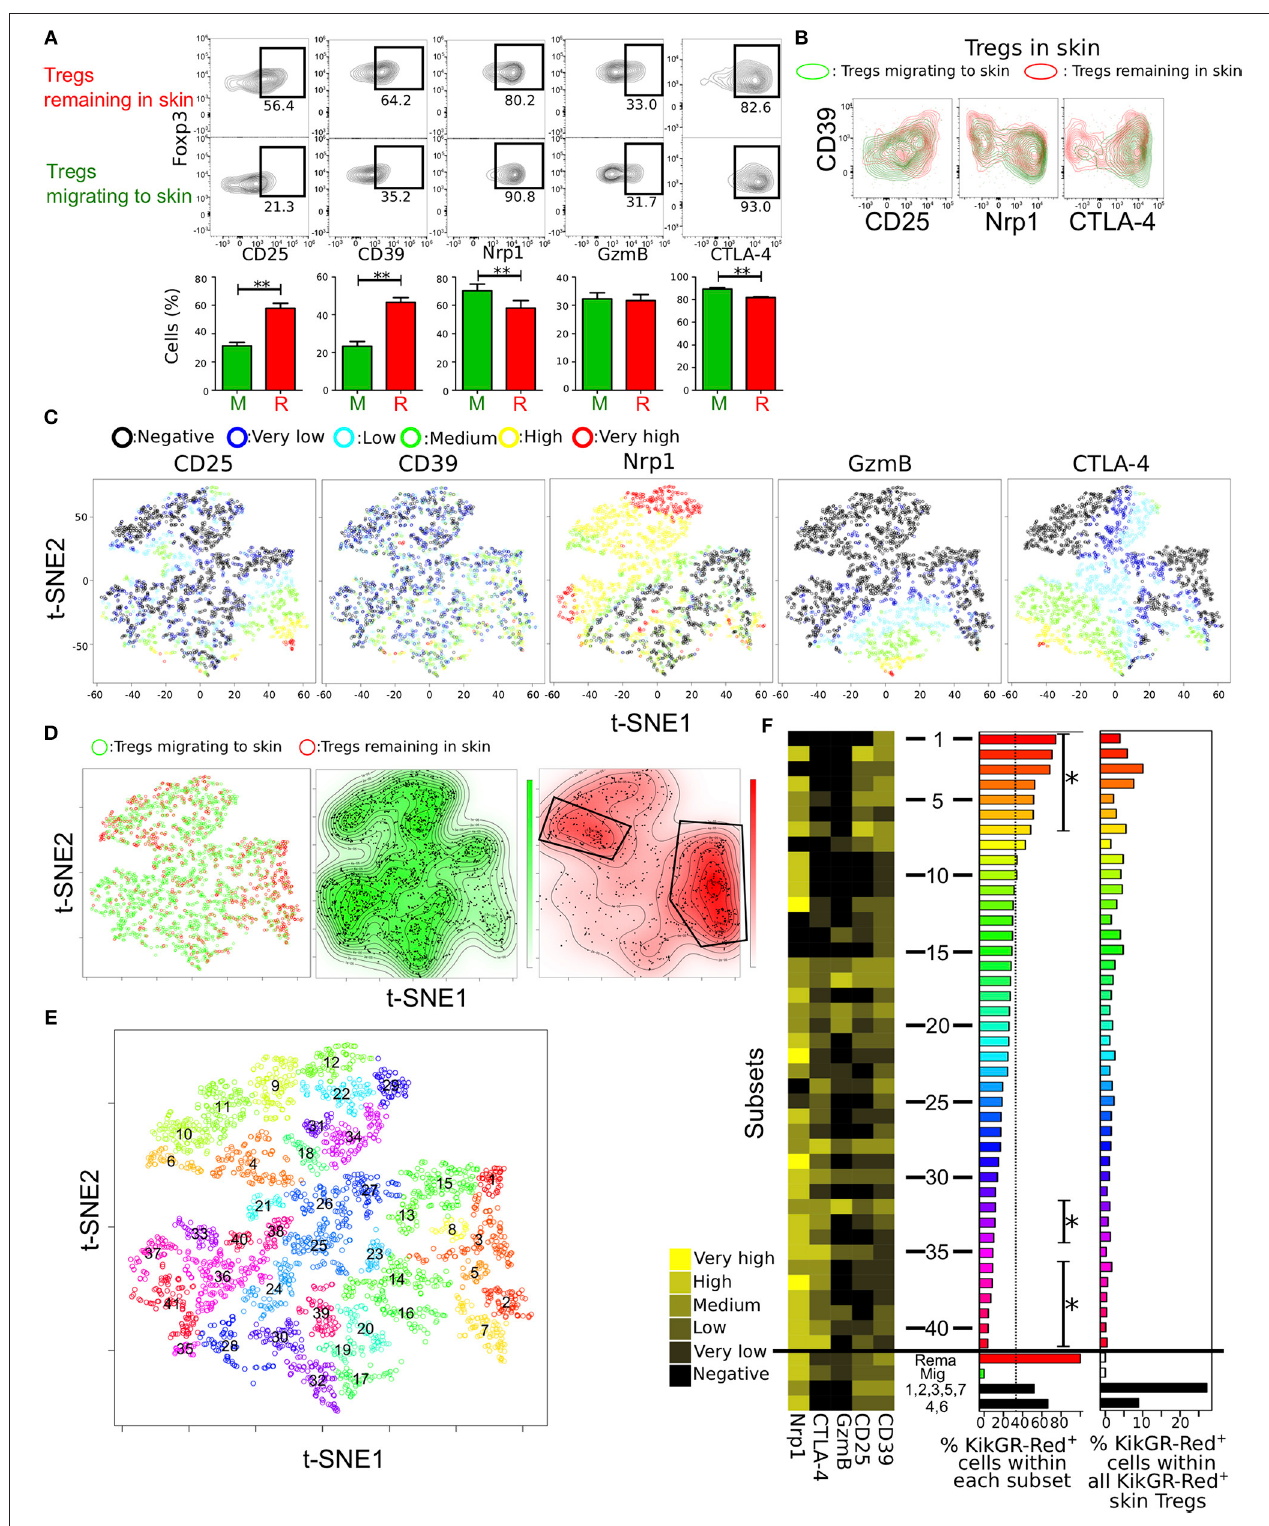
FIGURE 4 | Identification of distinct Treg subsets remaining in skin by automated clustering analysis of expression data. (A) Proportions of cells expressing each of five molecules related to Treg function in Tregs migrating to and remaining in skin ( n = 19, 23, 18, 12, and 8 for CD25, CD39, Nrp1, GzmB, and CTLA-4 expression, respectively). (B) Contour plots showing CD39 expression and each of CD25, Nrp1, and CTLA-4 expression in Tregs migrating to and remaining in skin. FCM data are